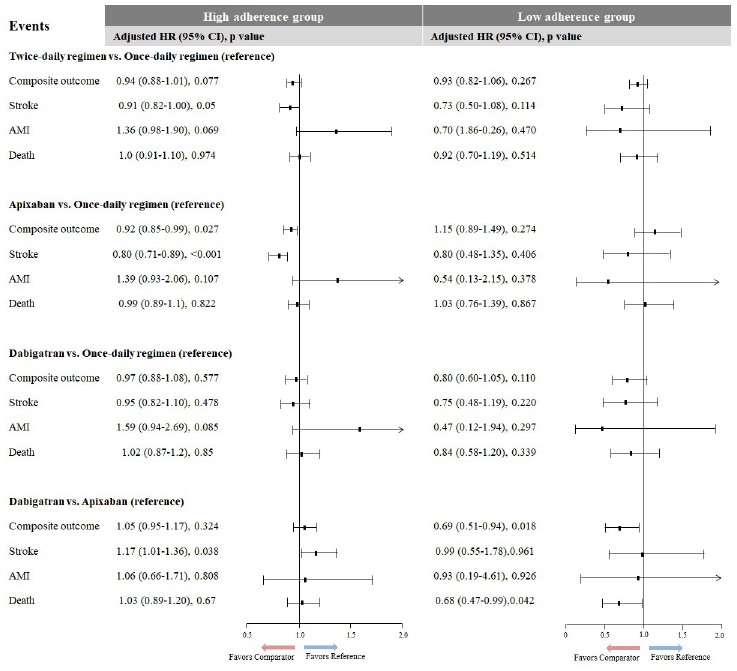
Fig 5. Comparative clinical outcomes of each NOAC in high and low adherence groups. NOAC, non-vitamin K antagonist oral anticoagulant; HR, hazard ratio; CI, confidence interval; AMI, acute myocardial infarction.